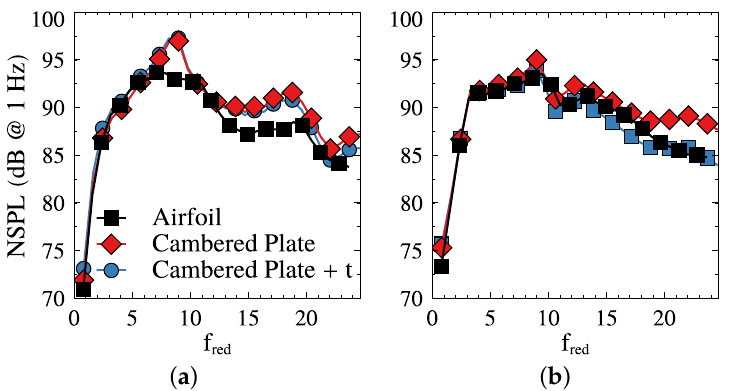
Figure 9. Assessment of the impact of blade turning on the broadband noise footprint at OP1. Subfig- ures ( a , b ) compare, respectively, the results with the airfoil and the cambered plate approximation at the inlet and